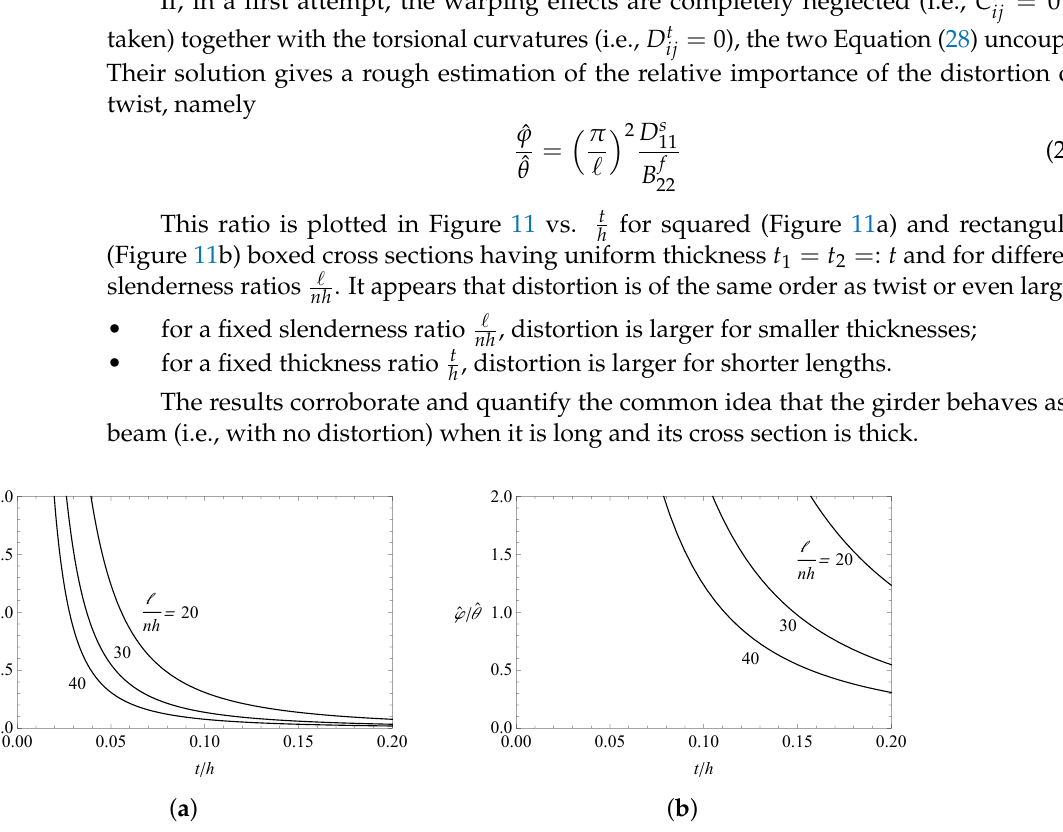
: ( a ) squared box nh